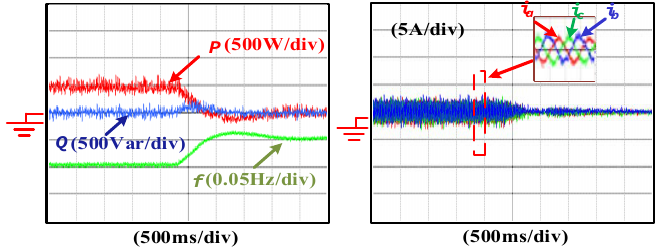
Figure 12. Experimental waveform of power and current when frequency increases.